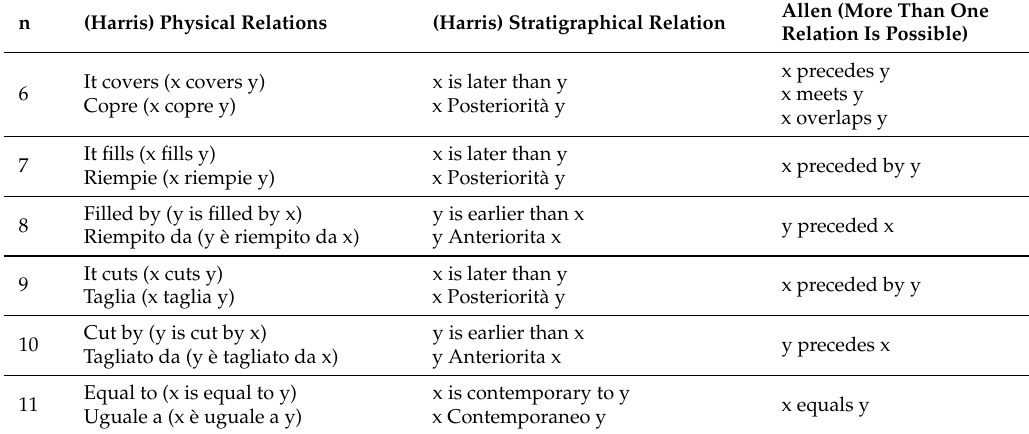
Figure 3. Allen’s intervals algebra atomic relations.